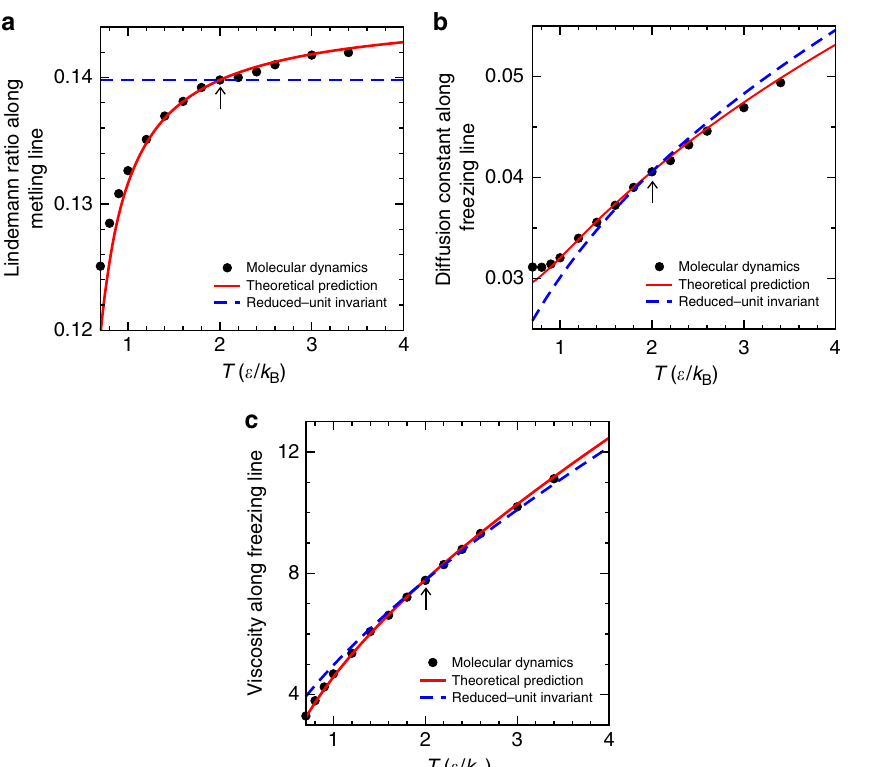
Figure 4 | Predictions (red curves) versus results of computer simulations (black dots) for three properties along the freezing/melting lines of the LJ system. The blue dashed lines show the predictions if perfect invariance of structure and dynamics in reduced units applies along the freezing/melting lines, the arrows indicate the reference state point upon which the predictions are based. ( a ) Lindemann ratio along the melting line. ( b ) Self-diffusion constant along the freezing line. ( c ) Viscosity along the freezing